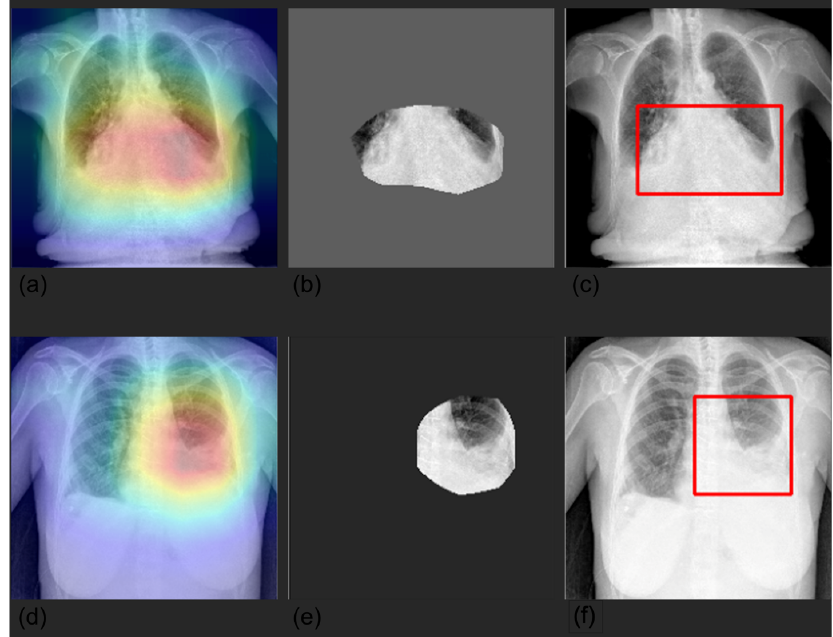
Figure 4. Visualization of pleura prediction maps for two selected CXRs. The panels represent the saliency mask obtained with Grad-CAM (panels a , d ), the relevant area (mask values higher than the 0.8 quantile (panels b , e )), and the respective bounding box (panels c , f ). The saliency mask focuses on plaura abnormalities, as shown by the heat map (panel a , d ).